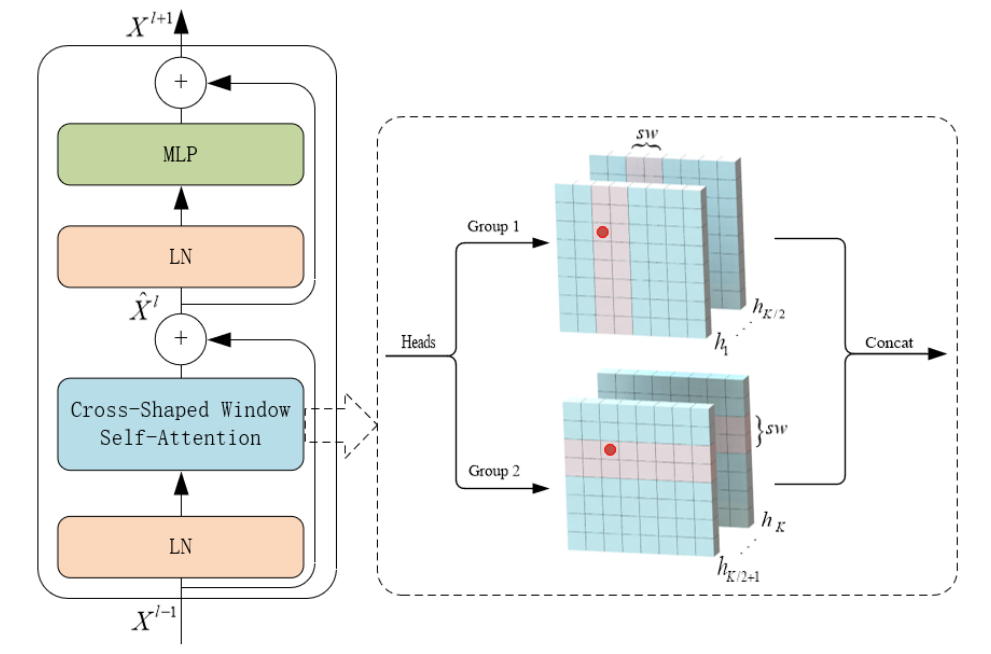
Figure 2. Structure of CSWin Transformer